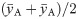
Monte Carlo simulation of the distribution of stochastic effects for point-biserial variation.2D histograms of MC distributions for (rpbd, μ) (A) and (rpbd, ρpb) (B) for ‘Emergency visits’ response with ‘Hospitalizations’ rCART split value, 3.3 (Table 2). The 1σ error bars for the rpbd histogram (A inset) serve as an indication of convergence for the simulation; the mean for the normal curve corresponds to the observed rpbd value, 0.398. rpbd: sample size corrected correlation, ρpb: nonoverlap proportion, μ: center of mass parameter (y¯A+y¯A)/2, number of MC runs: 25, samples per MC run: 4000.